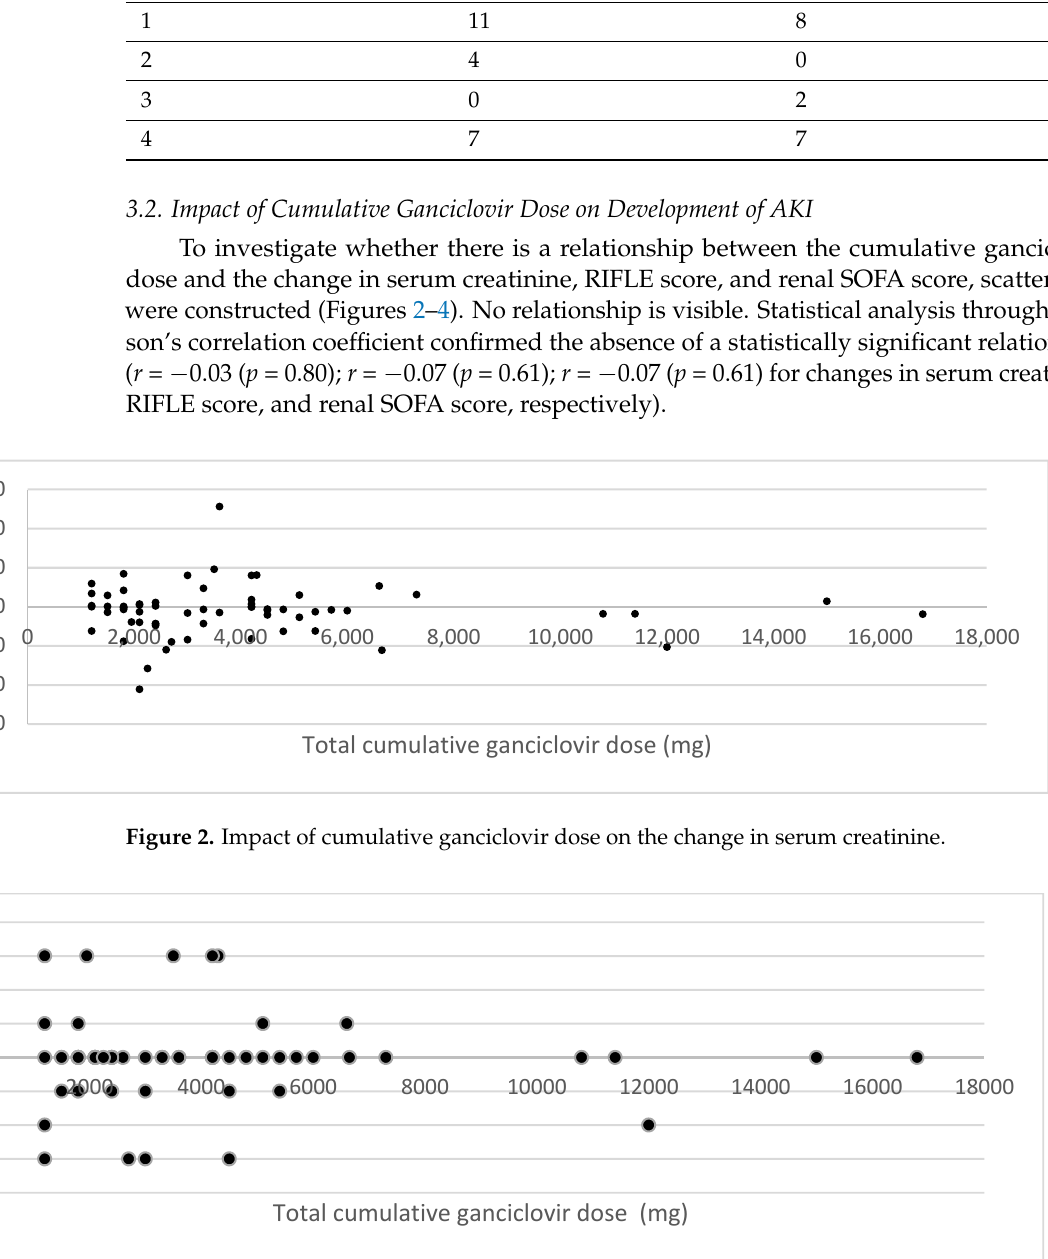
Figure 3. Impact of cumulative ganciclovir dose on the change in RIFLE score.